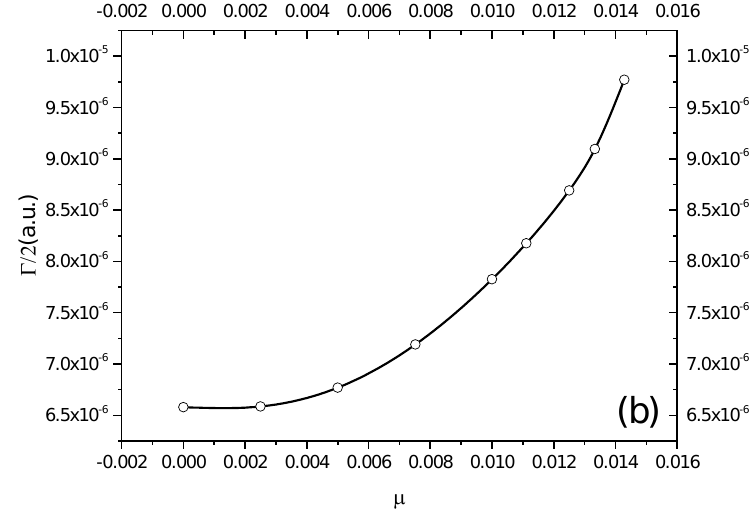
Figure 8. D -wave states with unnatural parity: ( a ) resonance energy and ( b ) half-width for the H(3d°-1) state, as a function of μ = 1/ D .